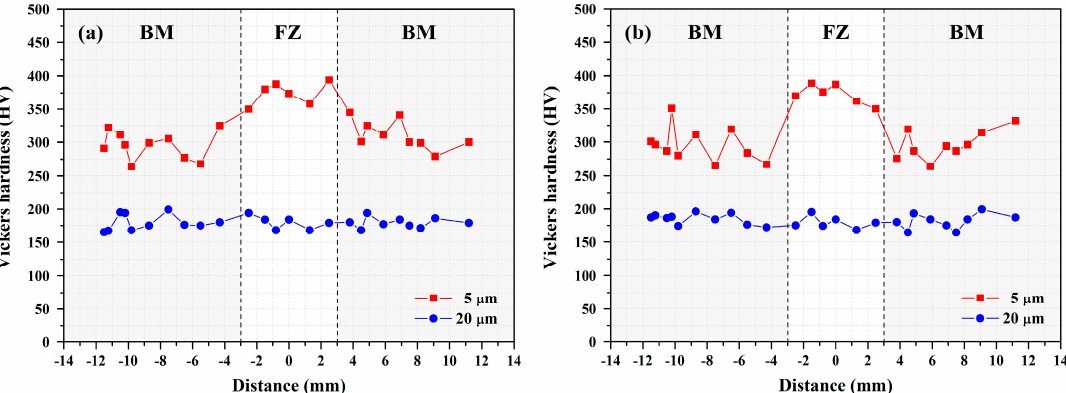
Figure 4. The hardness distributions across the FZs of the micro-shot peened ( a ) 304 and ( b ) 316 laser welds at depths of 5 and 20 μ m from the top surfaces of the welds.